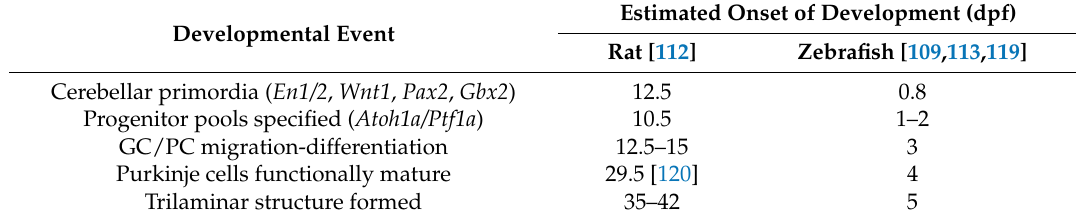
Table 2. Critical periods in the development of the cerebellum. Time periods represent approximate dates related to onset of neurogenesis, function and formation of structure. Time periods are approximated as days post-fertilization